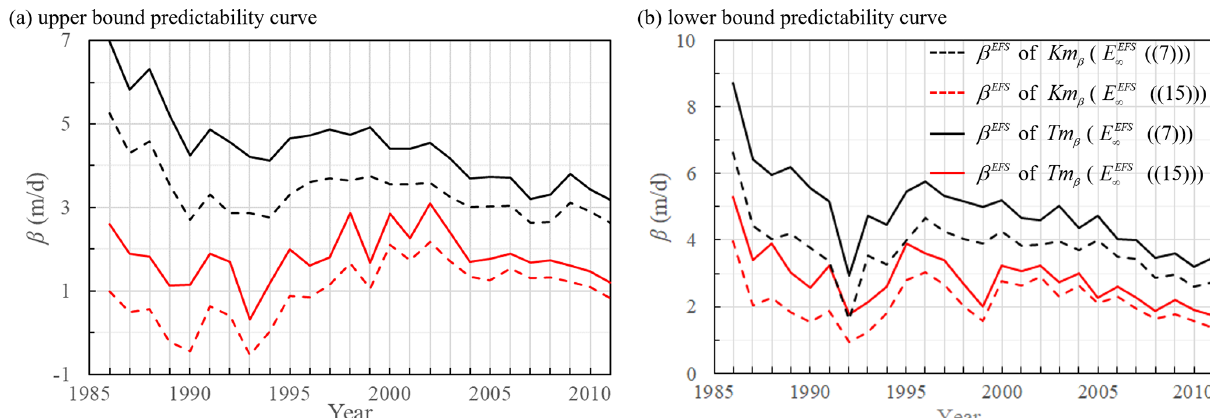
Figure 8. Parameters β EFS (a) for upper-bound predictability curves β EFS represent β EFS approximated from predictability curves with E EFS ∞ calculated by Eq. (7), red curves pertain to β EFS approximated from predictability curves with E EFS ∞ calculated by Eq. (15), full curves correspond to β EFS calculated from Tm β , and dashed curves correspond to β EFS calculated from Km β .